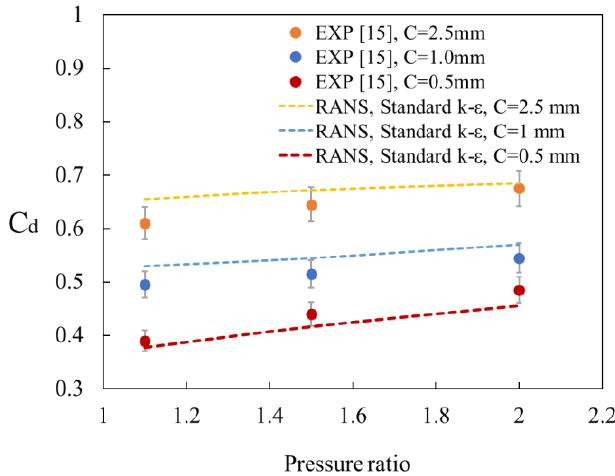
Figure 8. Effect of changing the clearance on the discharge coefficient of the labyrinth seal. C d — discharge coefficient.